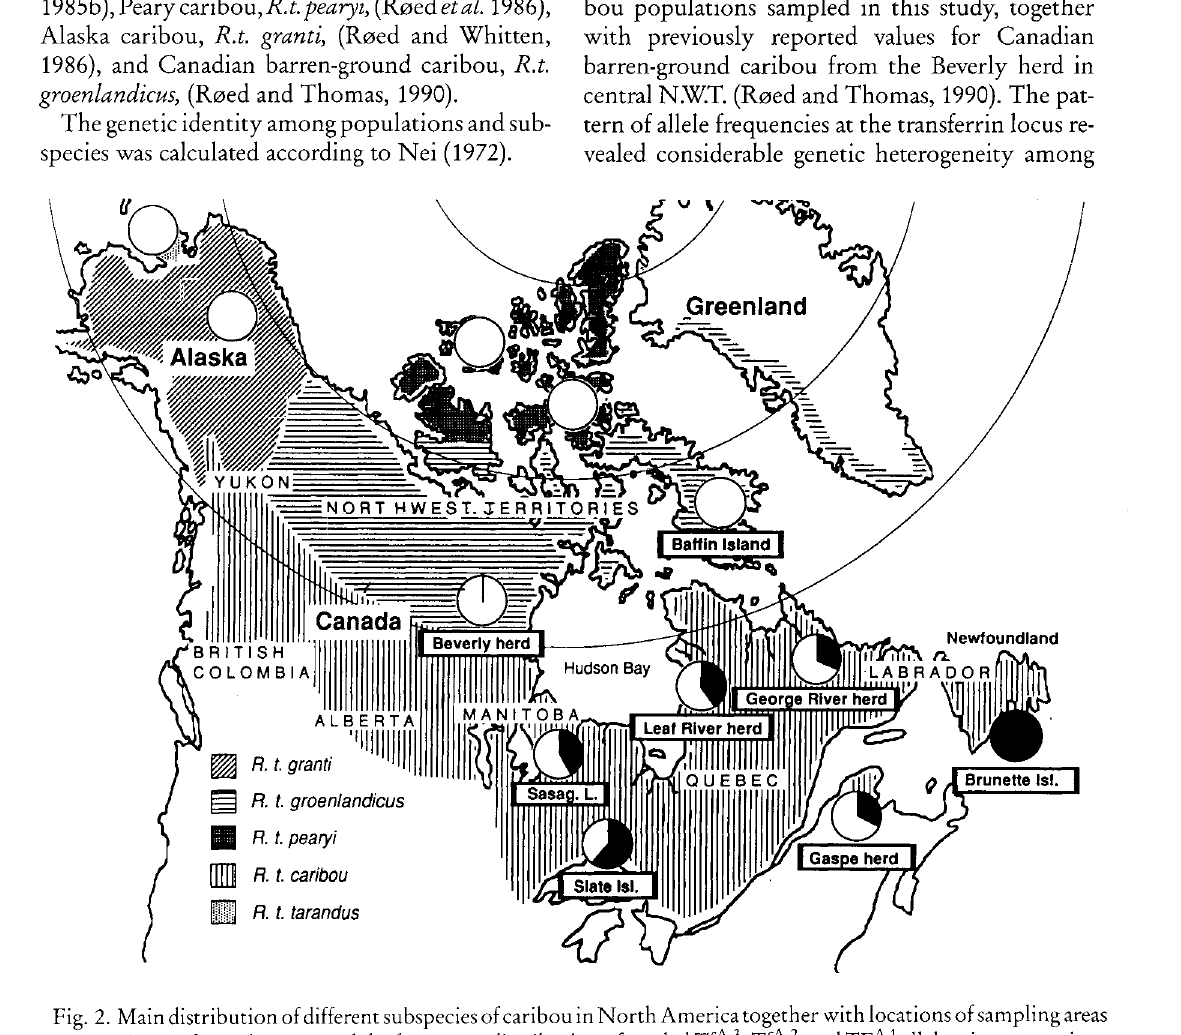
Fig. 2. Main distribution of different subspecies of caribou in North America together with locations of sampling areas given as framed names, and the frequency distribution of pooled Tf A " 3 , Tf A " 2 , and TF A_1 alleles given as sections of